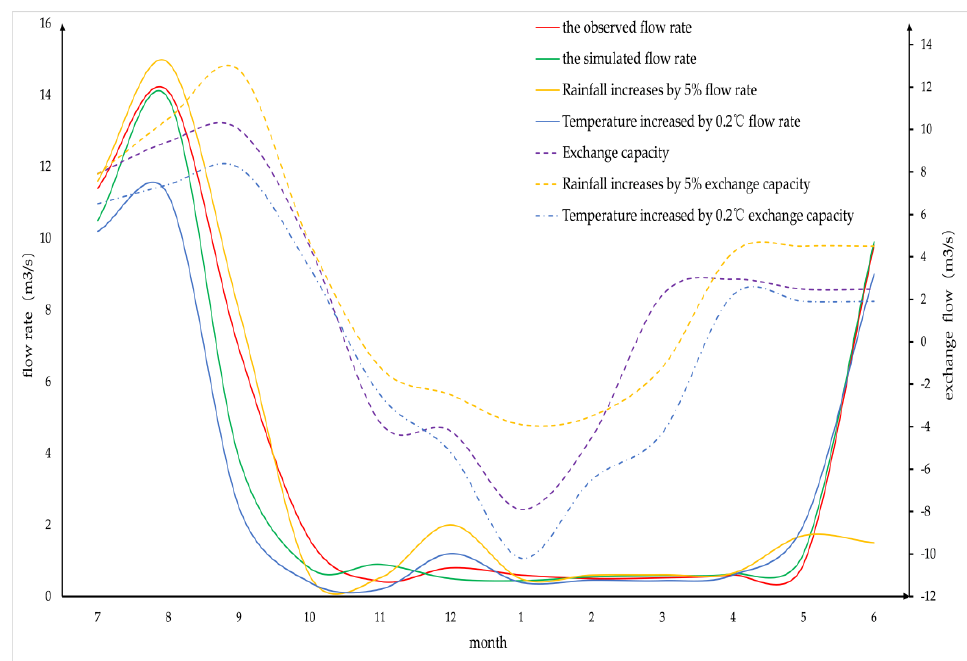
Figure 10. Flow changes under the climate change scenarios. groundwater discharge to surface water decreases, the surface water level rises, the cross-section discharge increases, the difference between surface water and groundwater levels increases, and the surface water supply to groundwater increases in the wet sea- son. Under a temperature increase of 0.2 °C, the evaporation of surface water is en- hanced, thus affecting the infiltration of soil water simultaneously. The cross-section discharge decreases, and the interaction between surface water and groundwater has a weakened effect. The overall trend was that the interaction quantity and the total runoff both decreased.